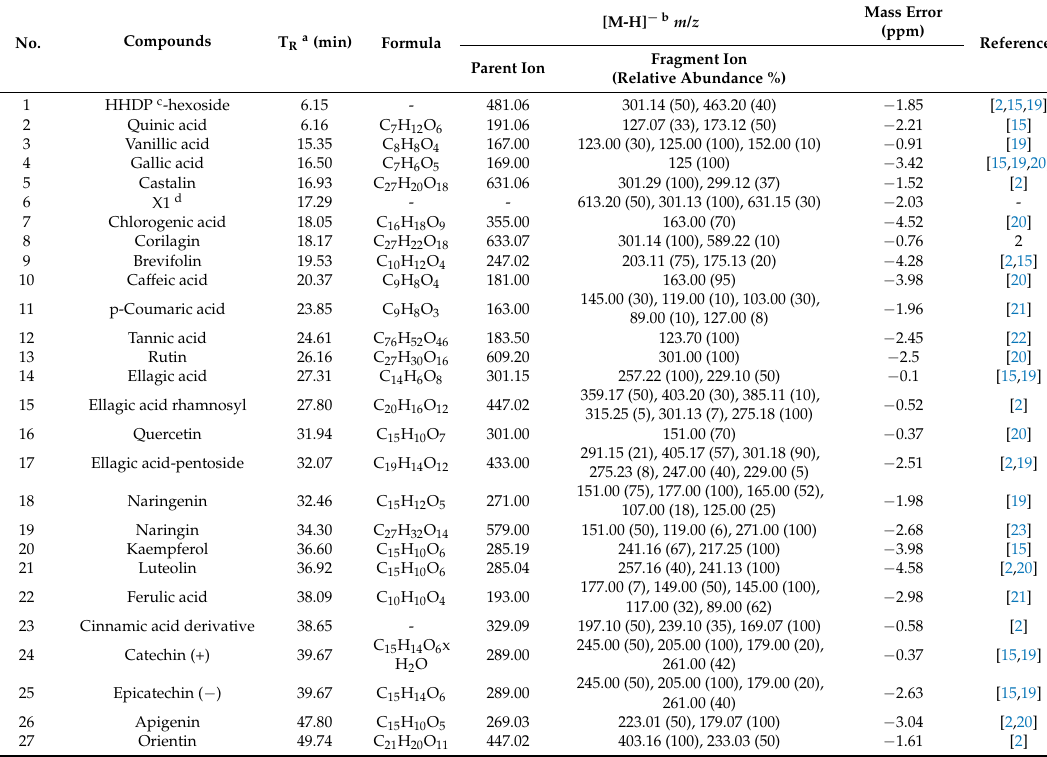
Table 2. Peak assignments and tentative identification of the phytochemical compounds in the N. alba extracts by HPLC-MS/MS in the negative ion